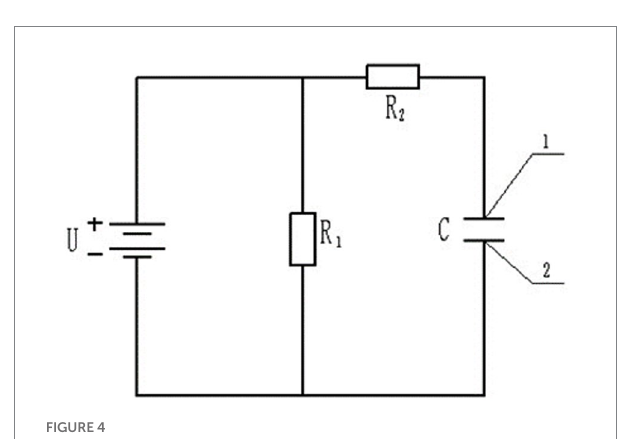
FIGURE 4 Equivalent circuit